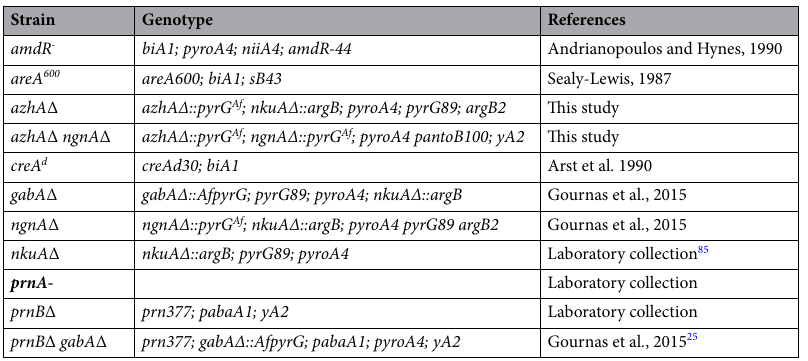
Table 1. A. nidulans strains used in this study.